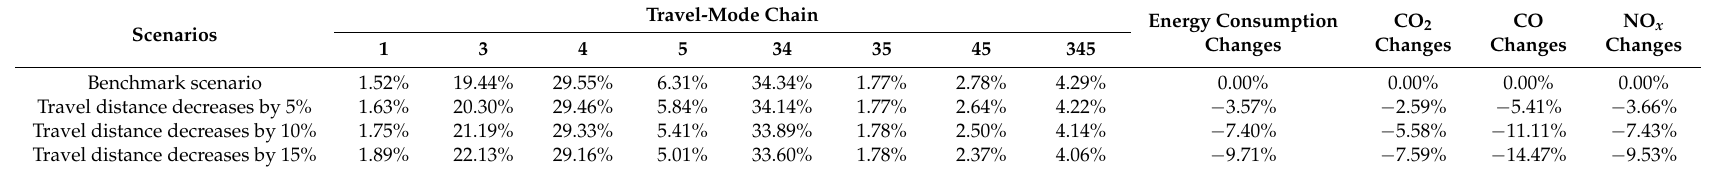
Table 11. Comparison of energy consumption and emissions at different travel distances in the holidays.